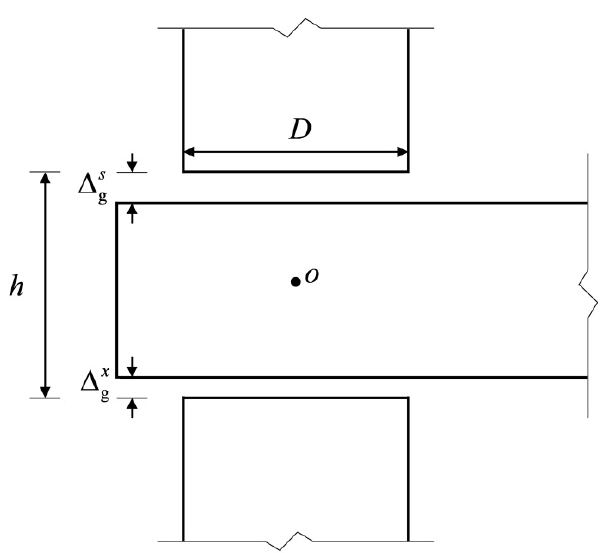
Figure 2. Diagram of SMTJ/WP.